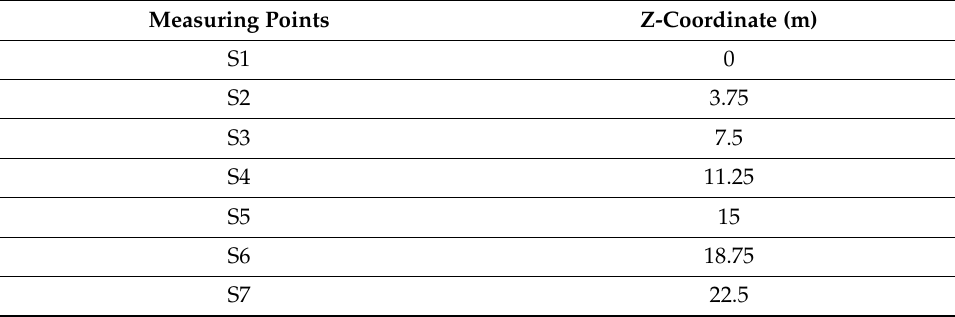
Figure 13. Location of measuring points. Table 5. Z-coordinates of measuring points.